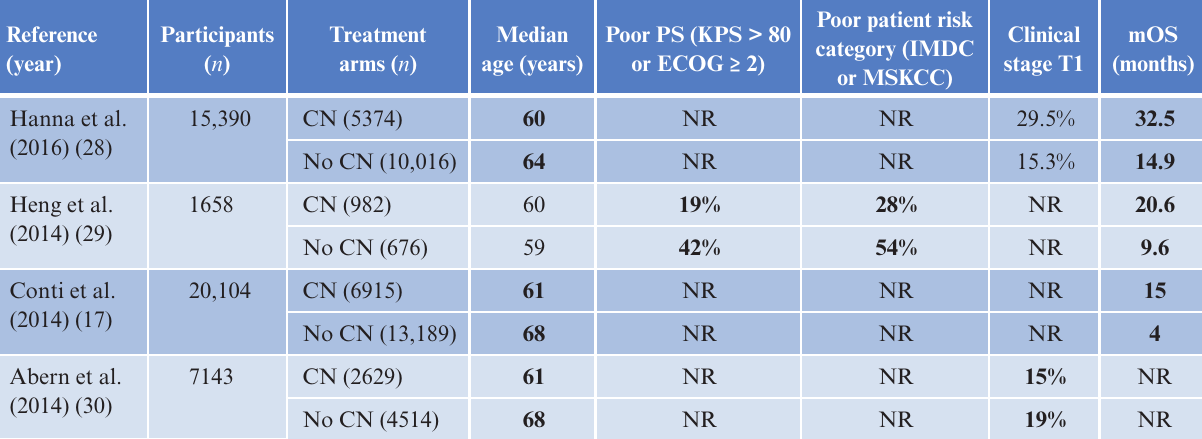
Table 1. Large (>1.000 patients) retrospective cohort studies evaluating the effect of cytoreductive nephrectomy on overall survival in